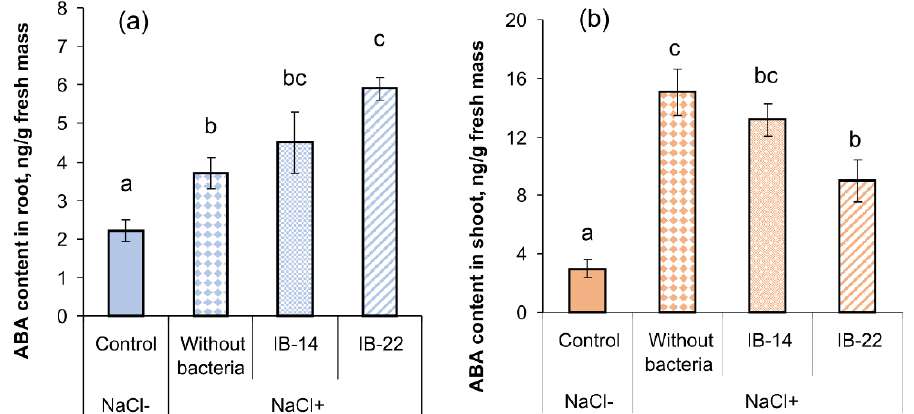
Figure 7. Effects of 100 mM NaCl and rhizospehere inoculation with P. mandelii IB -Кi14 (IB-14) and B. subtilis IB -22 (IB-22) on ABA concentration in roots ( a ) and shoots ( b ) of 11-days-old wheat plants. Control—option without bacterization and salinity. Significantly different means for each variable are labeled with different letters ( n = 6, p ≤ 0.05; LSD test).